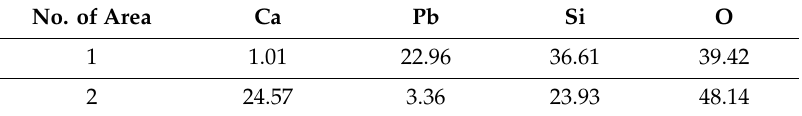
Figure 4. Silicate coating based on CaSiO 3 -PbSiO 3 system, after sintering (series 1). Magnifications: 9000 × ( a ), 25,000 × ( b ), 35,000 × ( c ), 70,000 × ( d ). Table 1. Elemental composition of phases marked as 1 and 2 in Figure 4 b,d (at.%). No. of